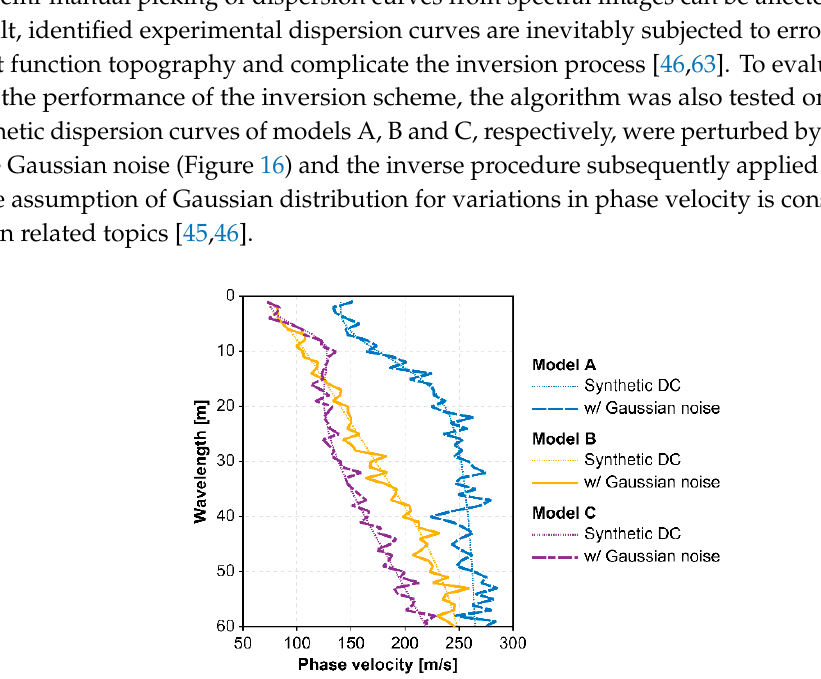
Figure 16. Fundamental mode dispersion curves for model A, model B and model C. The synthetic dispersion curves were perturbed by introduction of a 5% white Gaussian noise.